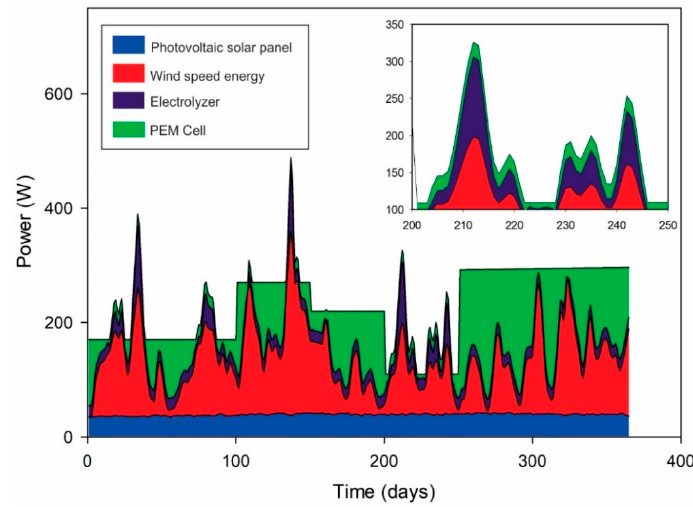
Figure 10. Power in Puerto Bolivar (Colombia).